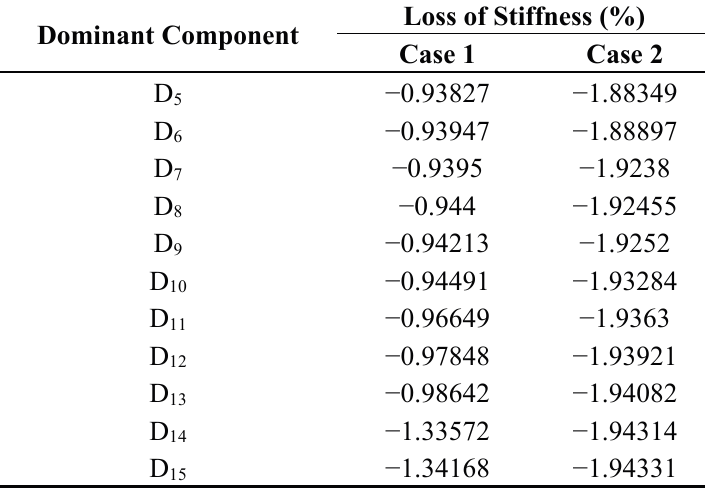
Figure 18. Loss of stiffness identification in each dominant component in Case 2. Table 3. Estimated values of loss of stiffness in the first convergence